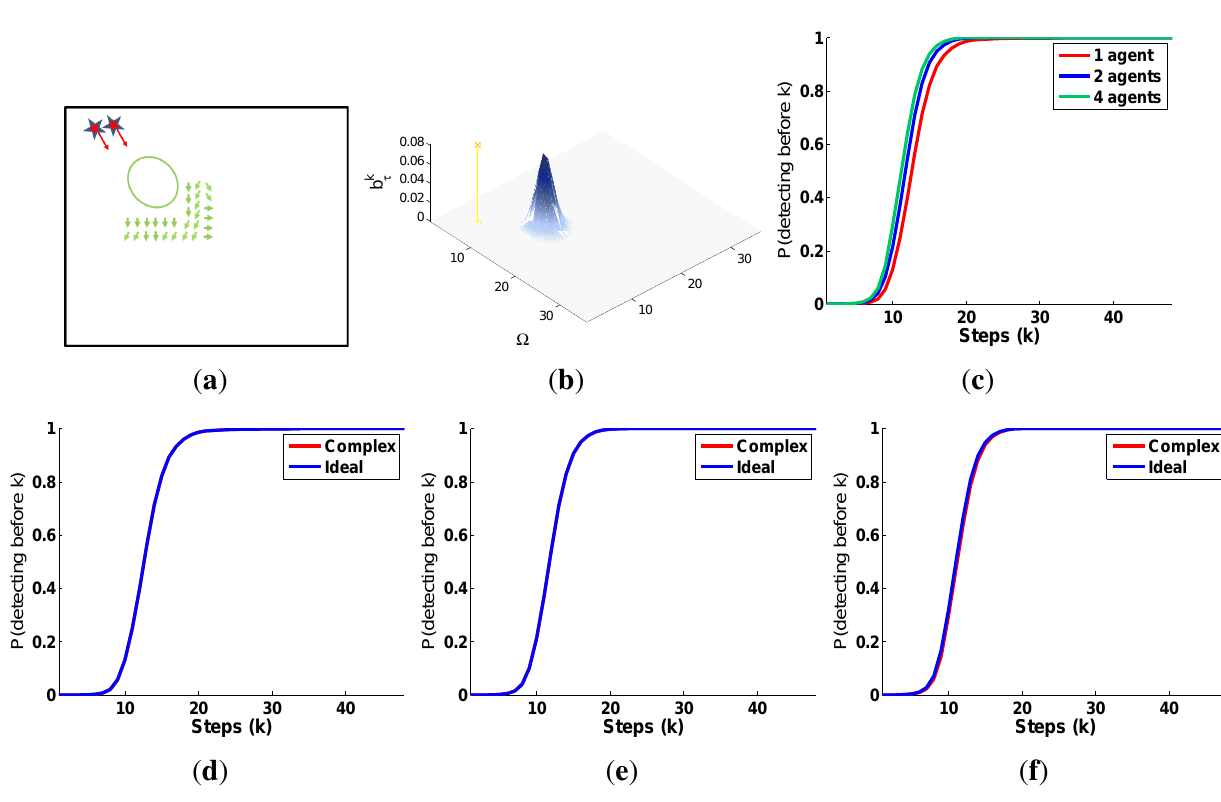
Figure 7. Properties and IG curves of the dynamic scenario of the radar experimental setup. ( a ) Schema; ( b ) Initial belief b ( τ 0 ) ; ( c ) IG, Complex; ( d ) IG, M = 1 ; ( e ) IG, M = 2